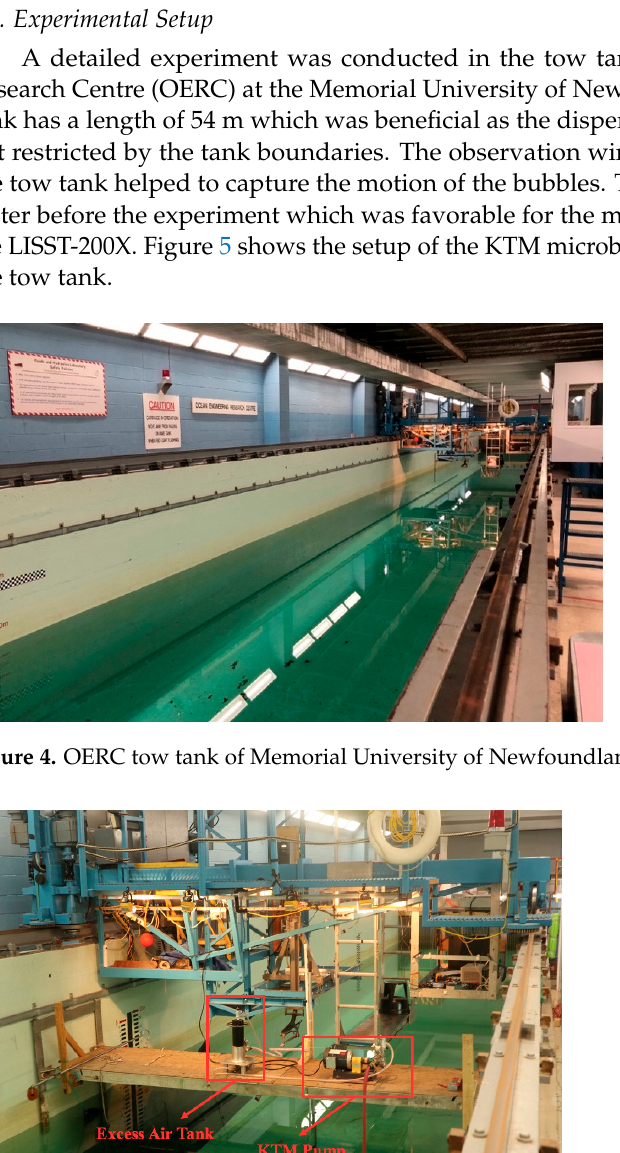
Figure 3. LISST-200X.